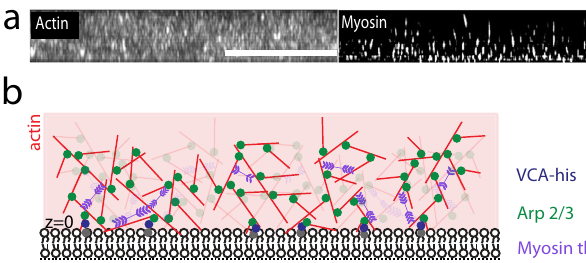
Fig. 9 | Arp 2/3-nucleated F-actin con fi nes myosin thick fi laments. a Super- resolutionz-stackimageforArp2/3-nucleatedF-actin(left),myosinthick fi laments (middle),andmergedimageofF-actin(magenta)andmyosin(cyan).Squareimage ontherightisazoomedinimageofmyosinthick fi lamentsembeddedinbranched